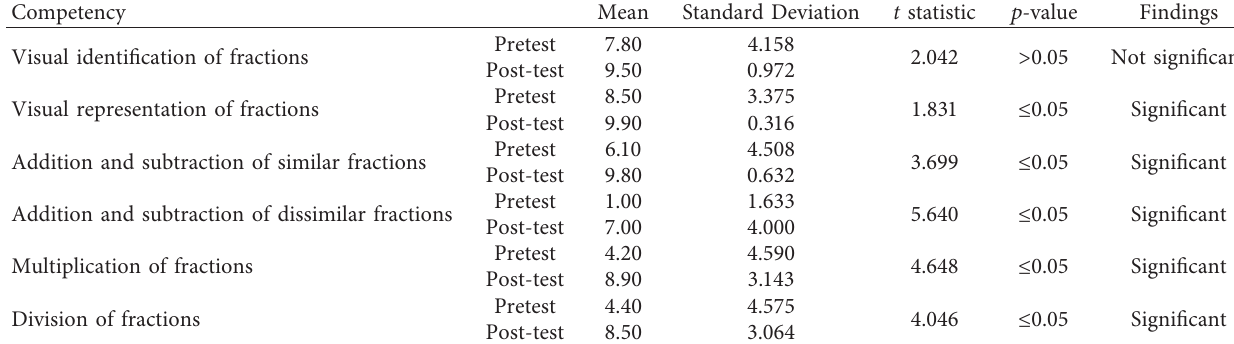
Table 2: Paired t -test of the pretest and post-test of the competencies of learning